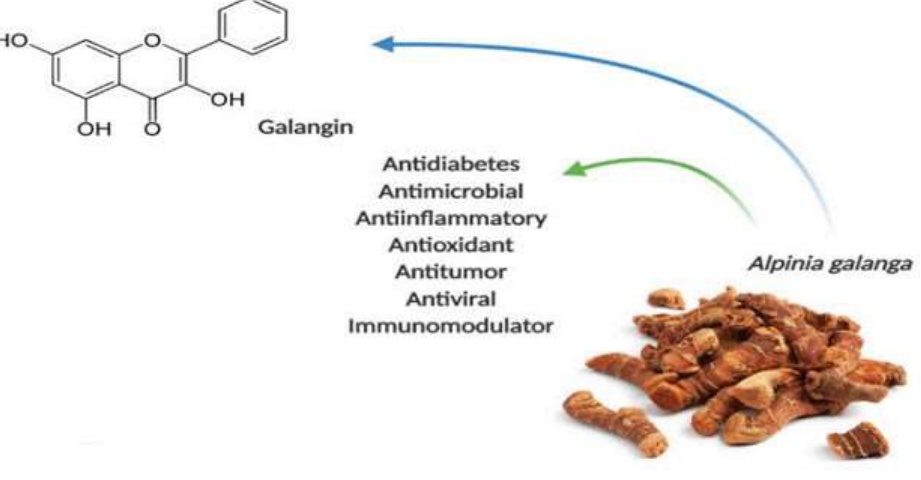
Figure 1: Molecular structure and biological activities of